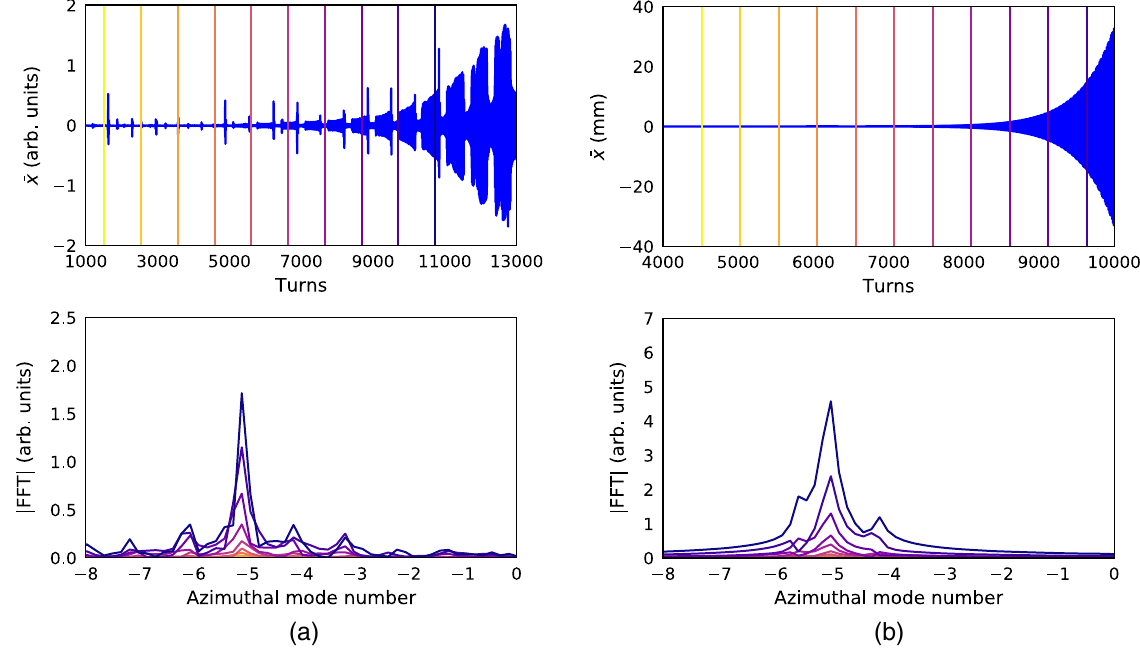
FIG. 10. Horizontal centroid from measurements (top left) and P y HEADTAIL simulations using the PSB impedance model (top right). Information on the azimuthal mode number is obtained by performing a sliding-window FFTon the centroid signals. Both cases predict an azimuthal mode number